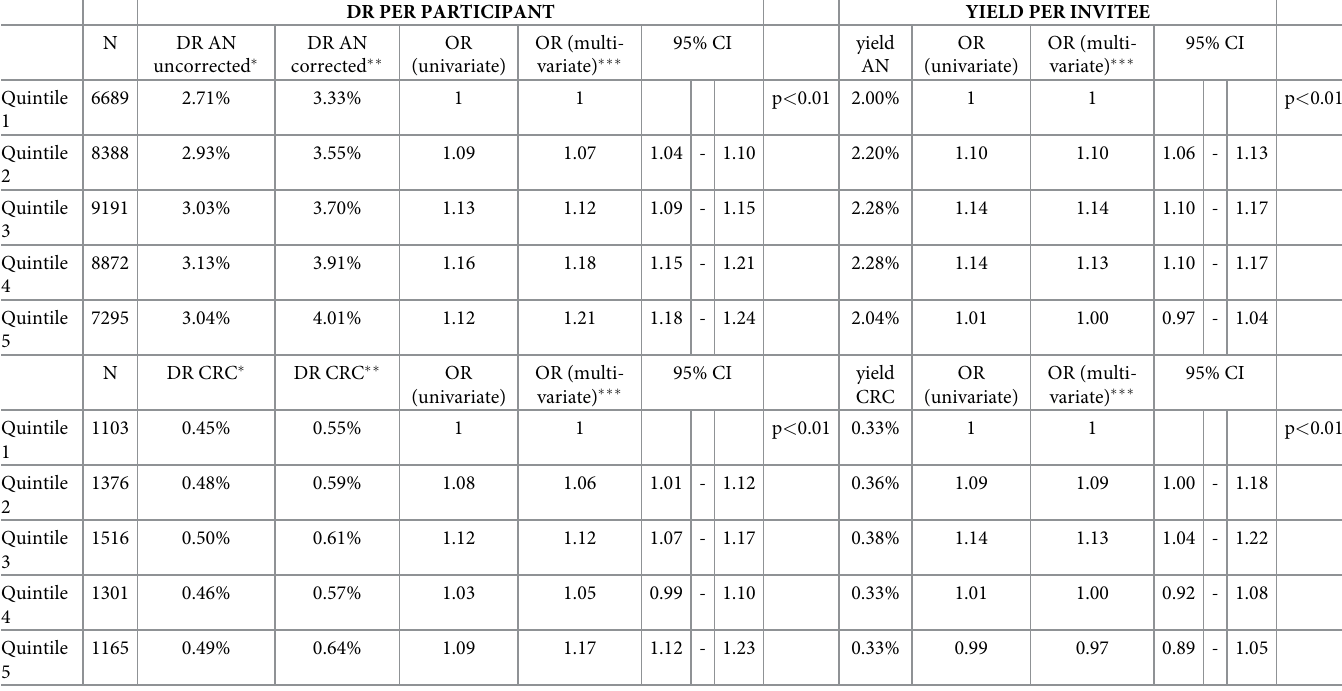
Table 4. The detection rate (DR) per 100 participants uncorrected and corrected for colonoscopy uptake and the yield per 100 invitees of advanced neoplasia (AN) and colorectal cancer (CRC) for each quintile, with the univariate and multivariate odds ratio (OR) and 95% CI. DR PER PARTICIPANT YIELD PER INVITEE N